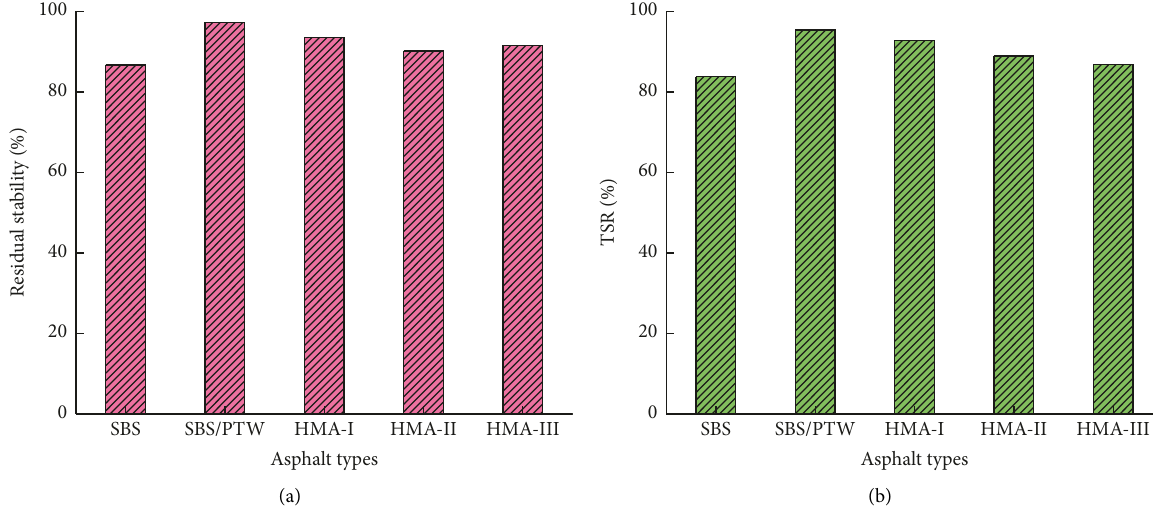
Figure 8: Water stability test results of asphalt mixture. (a) Immersion Marshall test. (b) Freeze-thaw splitting